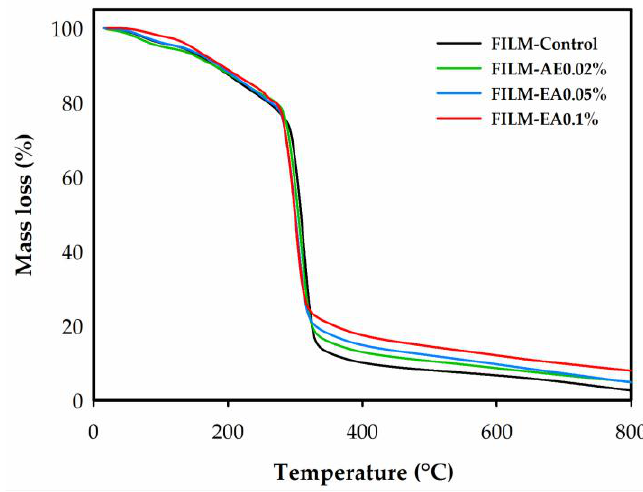
Figure 5. Thermogravimetric curves of apple starch films without ellagic acid (FILM-Control) and with ellagic acid (EA) added to 0.02% (FILM-EA0.02%), 0.05% (FILM-EA0.05%) and 0.1% (FILM- EA0.1%).